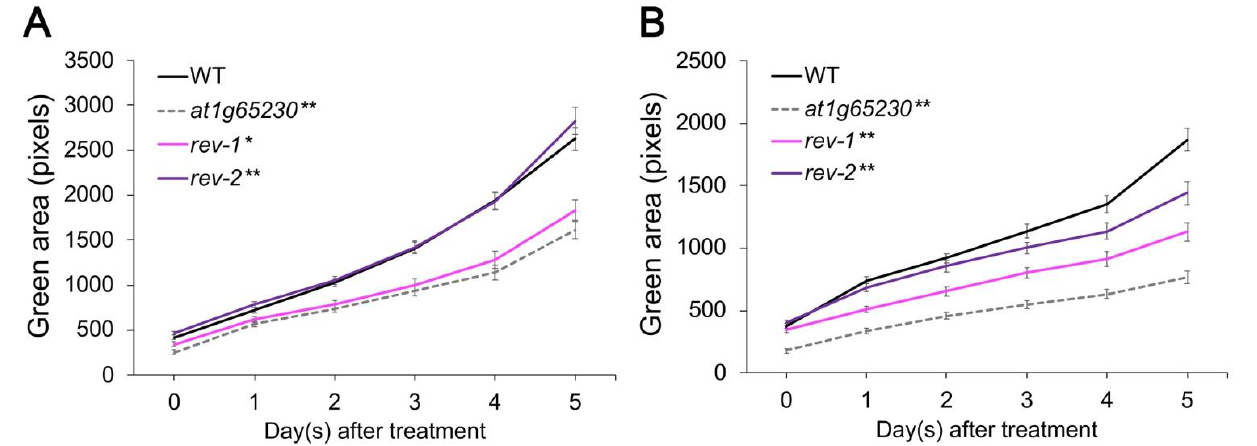
Figure 2. Total green area of the leaves in the Arabidopsis wildtype (WT) and revertant lines under the control conditions ( A ) and 75-mM NaCl stress ( B ). * represent the significant differences of the means ( p < 0.05) compared to WT and ** represent the highly significant differences of the means ( p < 0.01) compared to WT using a t -test. Error bars show standard error and the experiment was performed with n = 48.